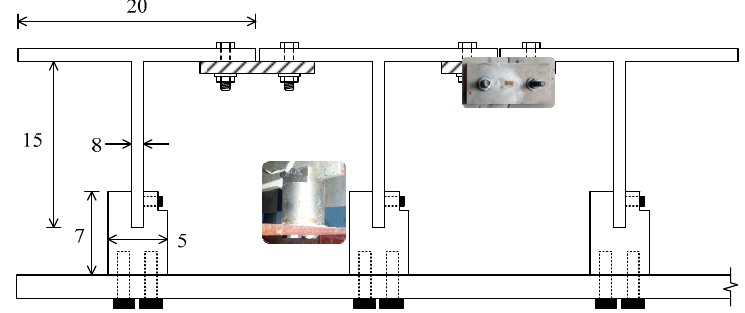
Figure 11. Detailed drawing of the cross-section of the three main beams of the model bridge (unit: